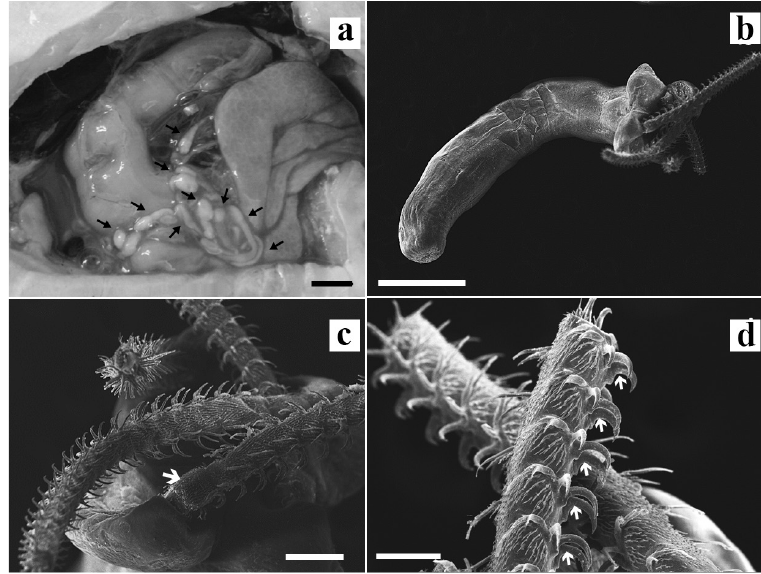
Figure 1 - Pterobothrium crassicolle plerocerci parasitizing Paralichthys orbignyanus : a. Plerocerci in the visceral serosas (arrows). b-d. Plerocercus by scanning electron microscopy. b. Entire worm. c. Distinctive basal armature with swelling on the external surface of tentacle (arrow). d. Falciformes macrohooks row on the internal face of tentacle (arrows). The scale bars in a = 0.5 cm, b = 1 mm, c = 200 µm and d = 100